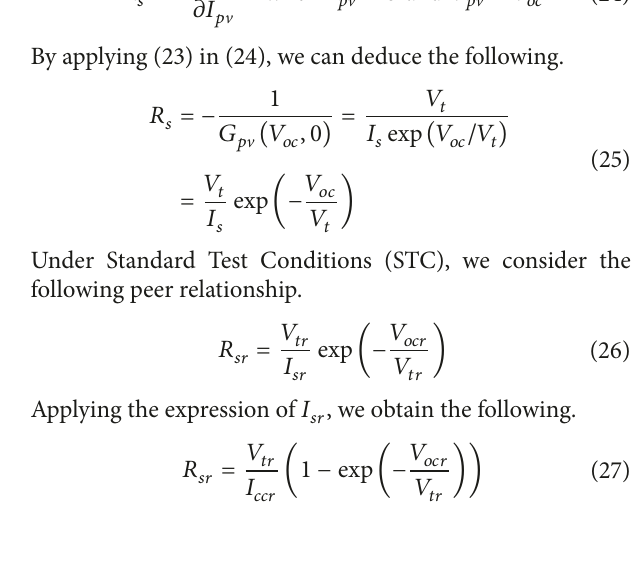
Figure 6: Influence of shunt resistance on the 𝐼 𝑝 V = 𝑓(𝑉 𝑝 V ) characteristic.